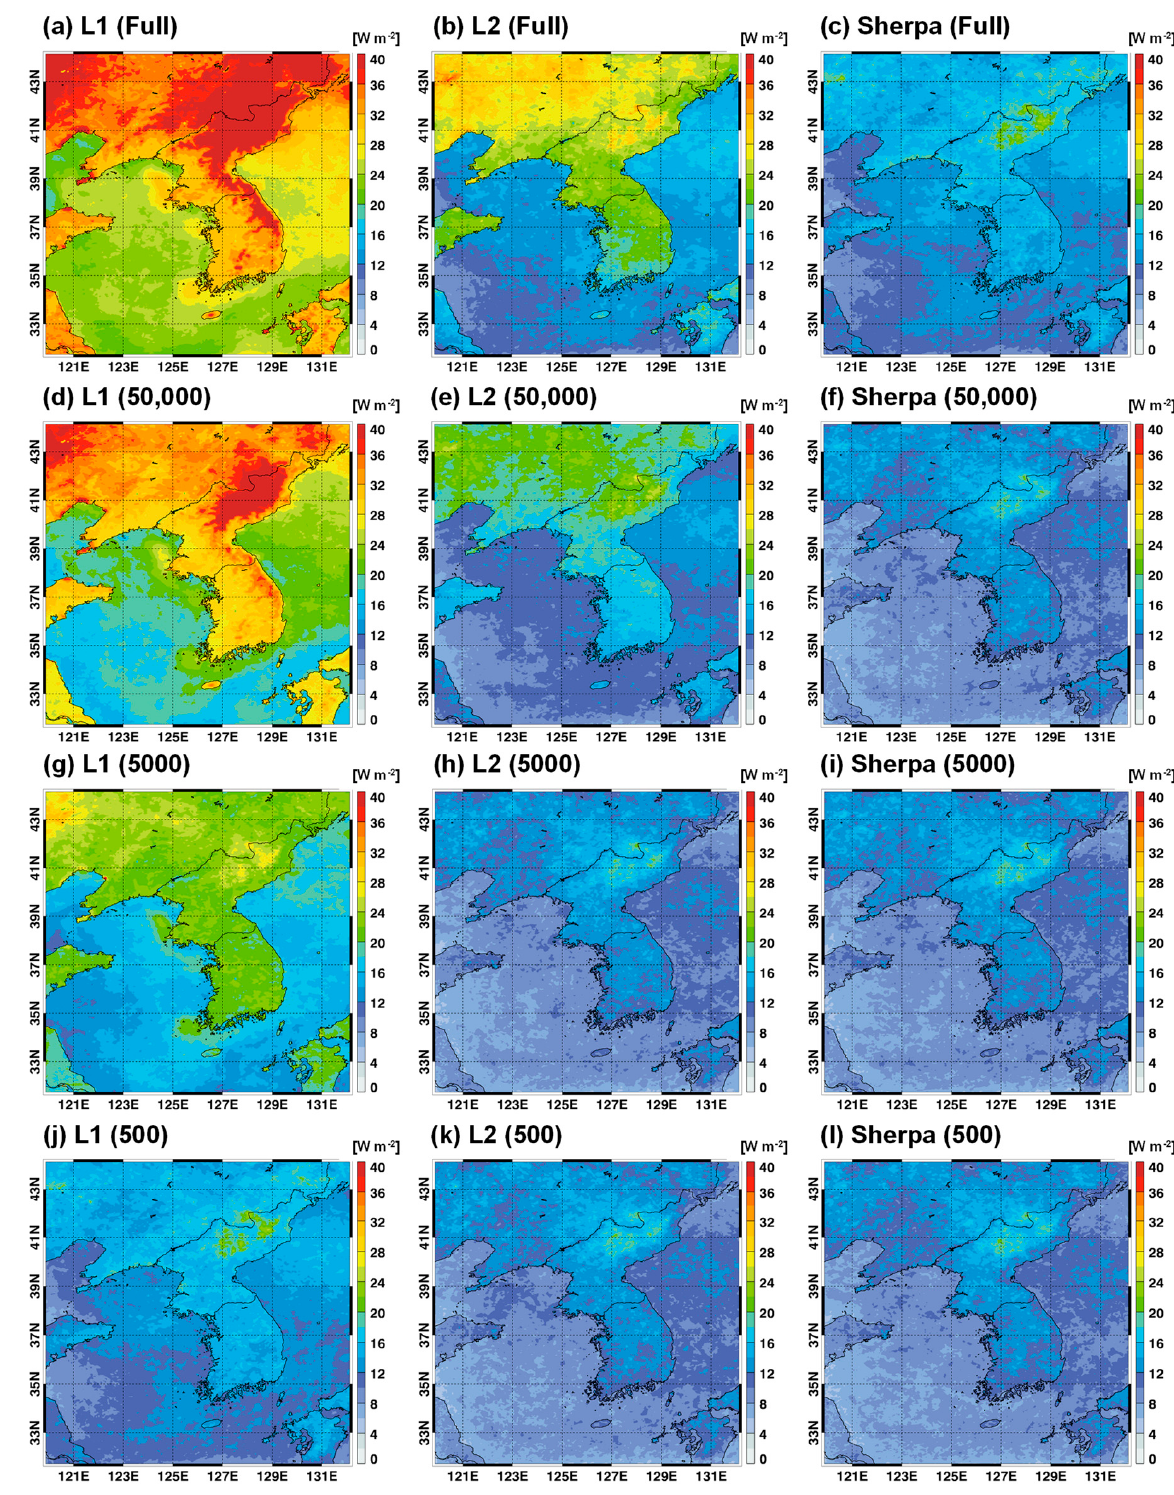
Figure 5. Spatial distributions of the root mean square errors (RMSEs) for LW flux simulated from radiation emulators based on different batch sizes ( a – c : Full, d – f : 50,000, g – i : 5000, j – l : 500) and learning rates (L1, L2, and Sherpa). Four weekly cases and 7-day forecast period were used to calculate the RMSE at each location.